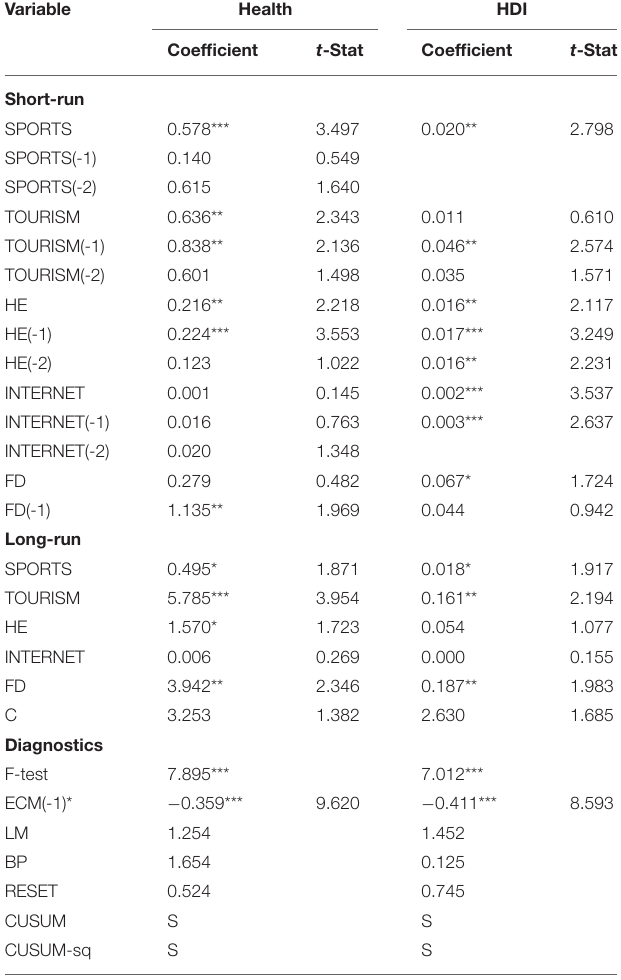
TABLE 3 | Short and long-run estimates of health and human